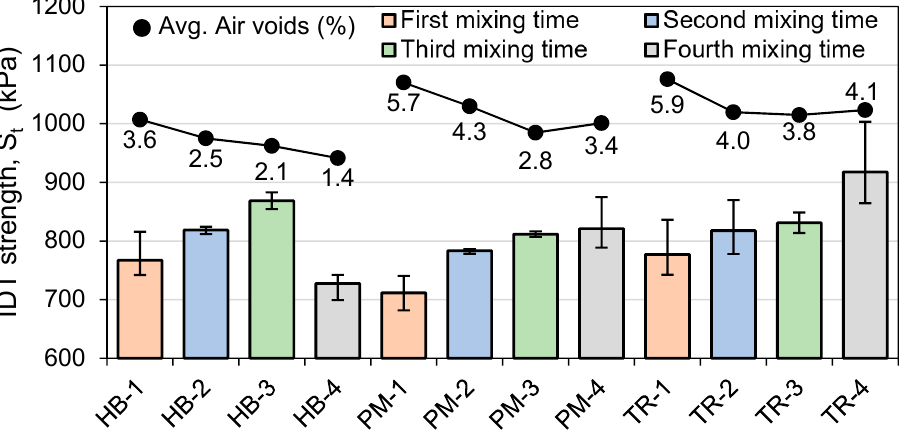
Figure 11. Indirect tensile strength (IDT) results at 25 °C ( n = 3).